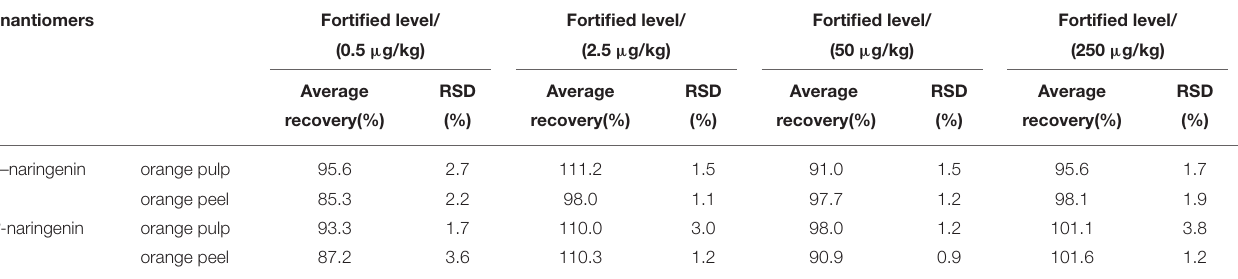
TABLE 2 | Recoveries of naringenin enantiomers in orange matrix ( n = 5).